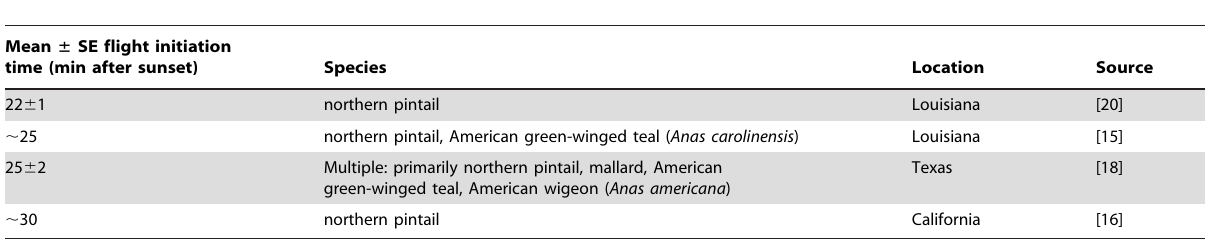
Table 1. Mean evening flight initiation time for wintering dabbling duck species at various locations.